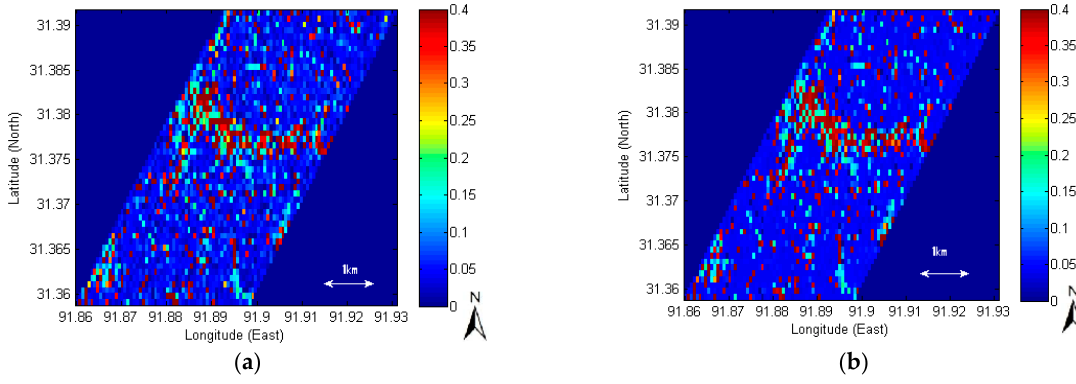
Figure 7. Surface soil moisture on DoY 224 (m 3 /m 3 ): ( a ) EnOI; (b ) EnKF.